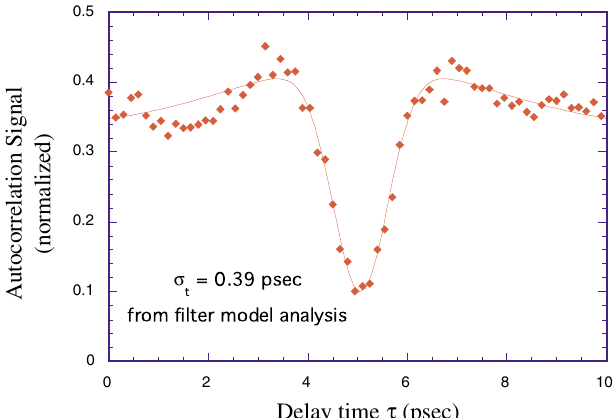
FIG. 9. (Color) Autocorrelation of optimally compressed beam in Neptune ballistic bunching experiment, with time-domain fit